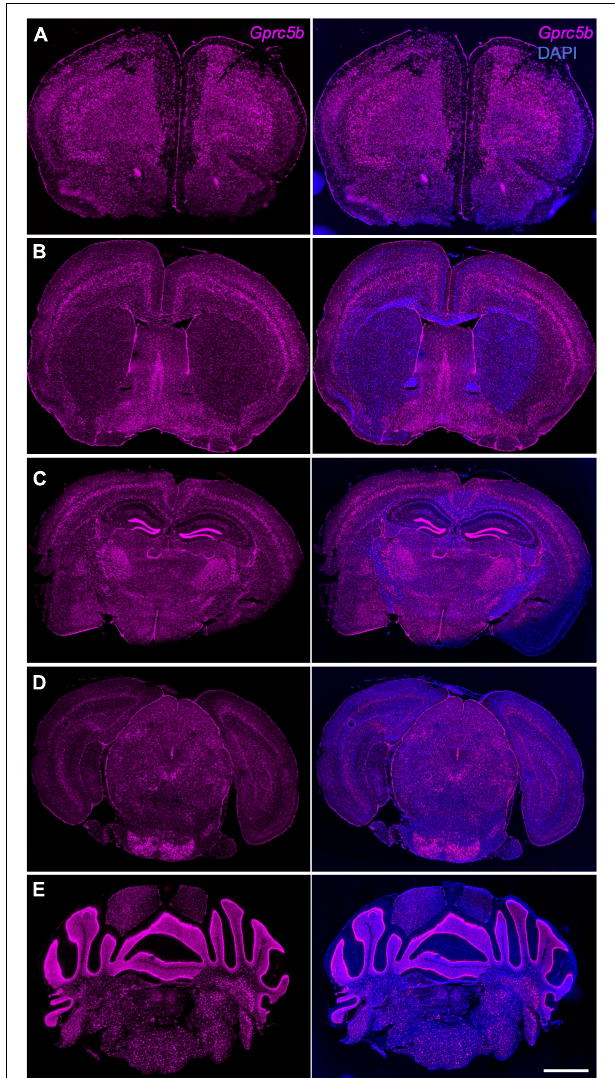
FIGURE 4 | Gprc5b mRNA distribution patterns determined by in situ hybridization. Coronal mouse brain sections showing Gprc5b mRNA expression is highly abundant in layer 5 of the cortex (A–C) , sparsely expressed in striatal regions (B) , highly expressed within SEZ, SVZ, and SGZ (A–C) , and enriched in pontine nuclei as well as in cerebellar Purkinje cells (D,E) . Scale bar: 500 µ m. SEZ, subependymal zone; SVZ, subventricular zone; SGZ, subgranular